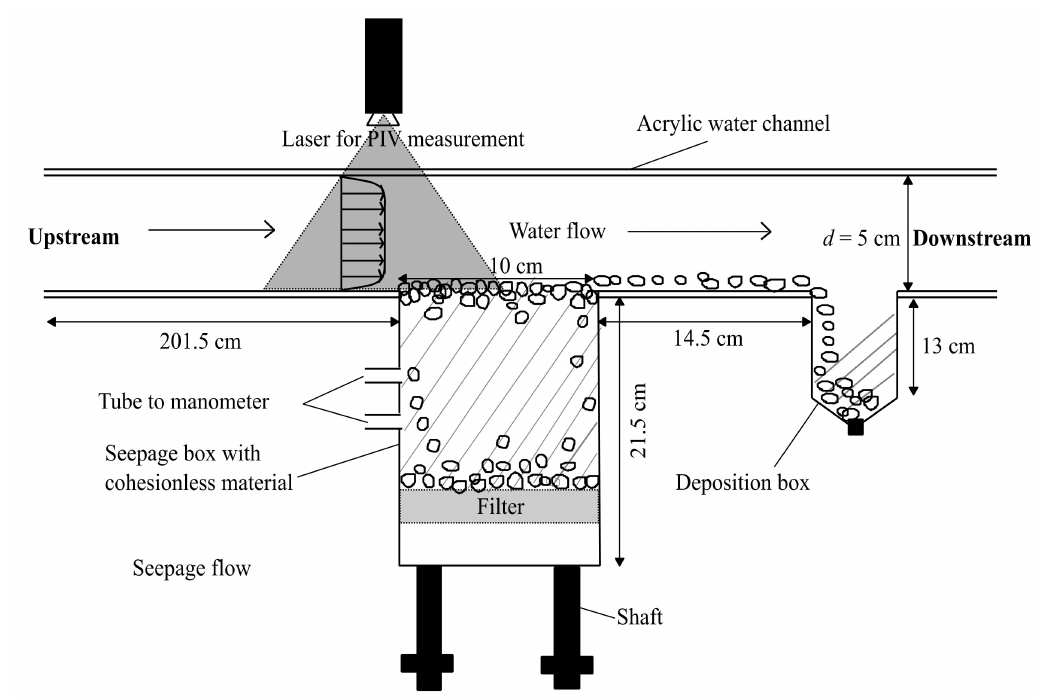
Figure 1. Experimental apparatus (not in